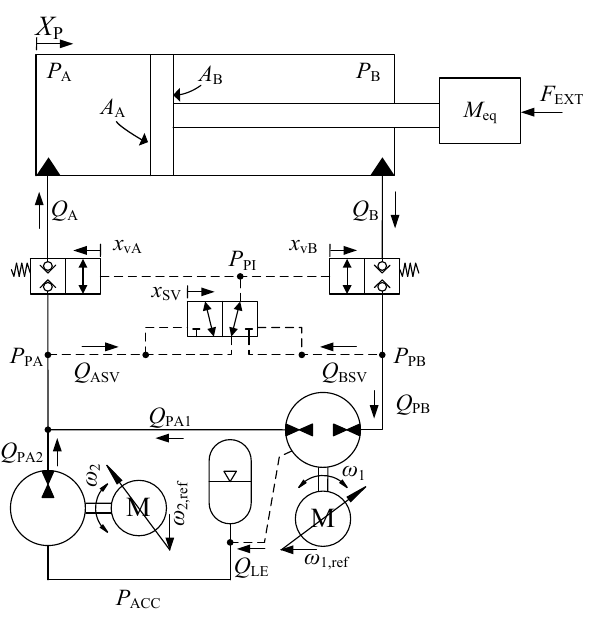
Figure 6: Asymmetric cylinder controlled by DvSP-